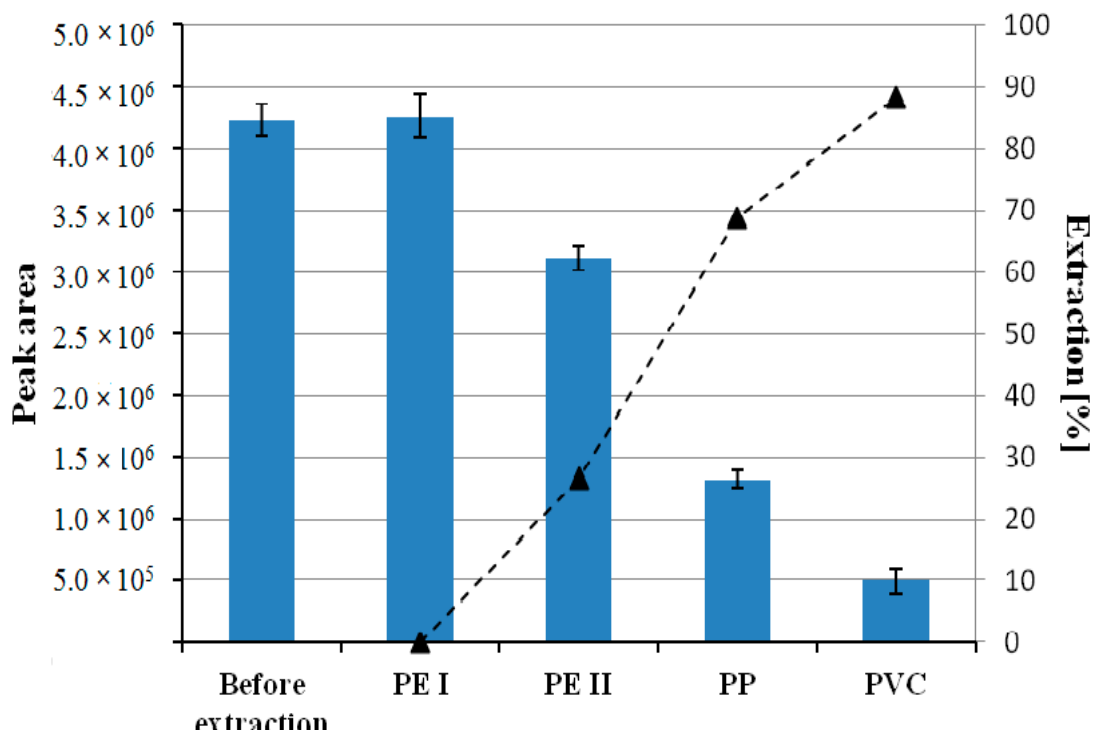
Figure 1. Peak area of chlorophyll a (the bar graph) and extraction efficiency [%] (the triangle signs) before extraction after mixing 0.5 mL of spinach leaf extract, 1.5 mL of acetone, and 1 mL of deionized water, with 0.3090 g of polyvinyl chloride (PVC), 0.3179 g of high-density polyethylene (HDPE), 0.3081 g of low-density polyethylene (LDPE), 0.3038 g of polypropylene (PP). The samples were placed in a rotor at maximum speed for 1 h and then determined by chromatography.